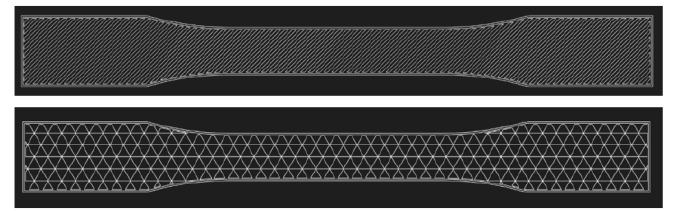
Figure 21. Infill patterns of rectilinear ( up ) and triangular ( down ).